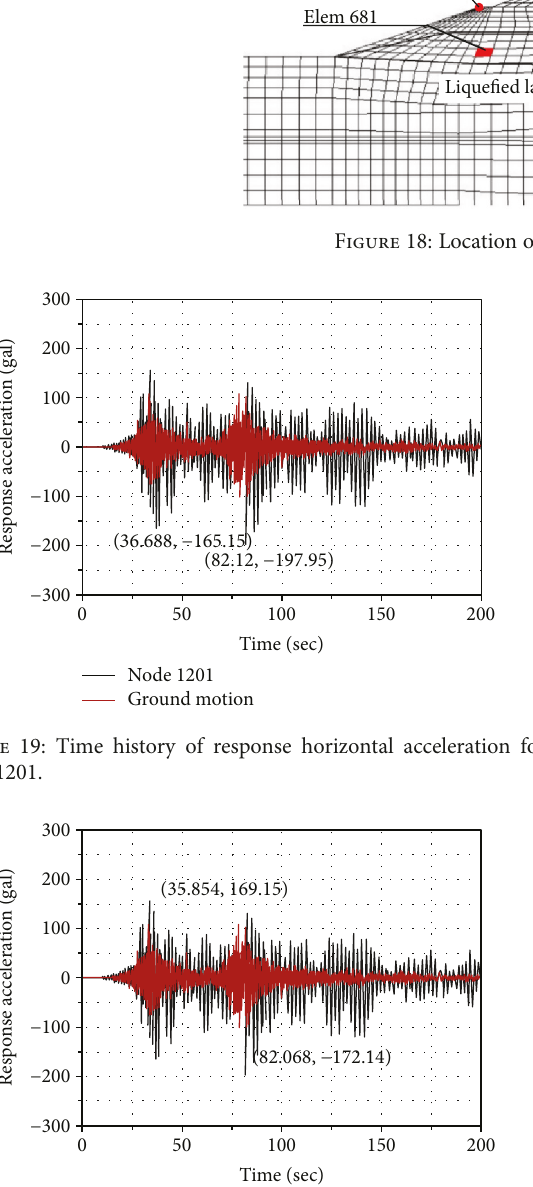
Figure 22: Time history of mean e ff ective stress for element 681 and element 865 during dynamic